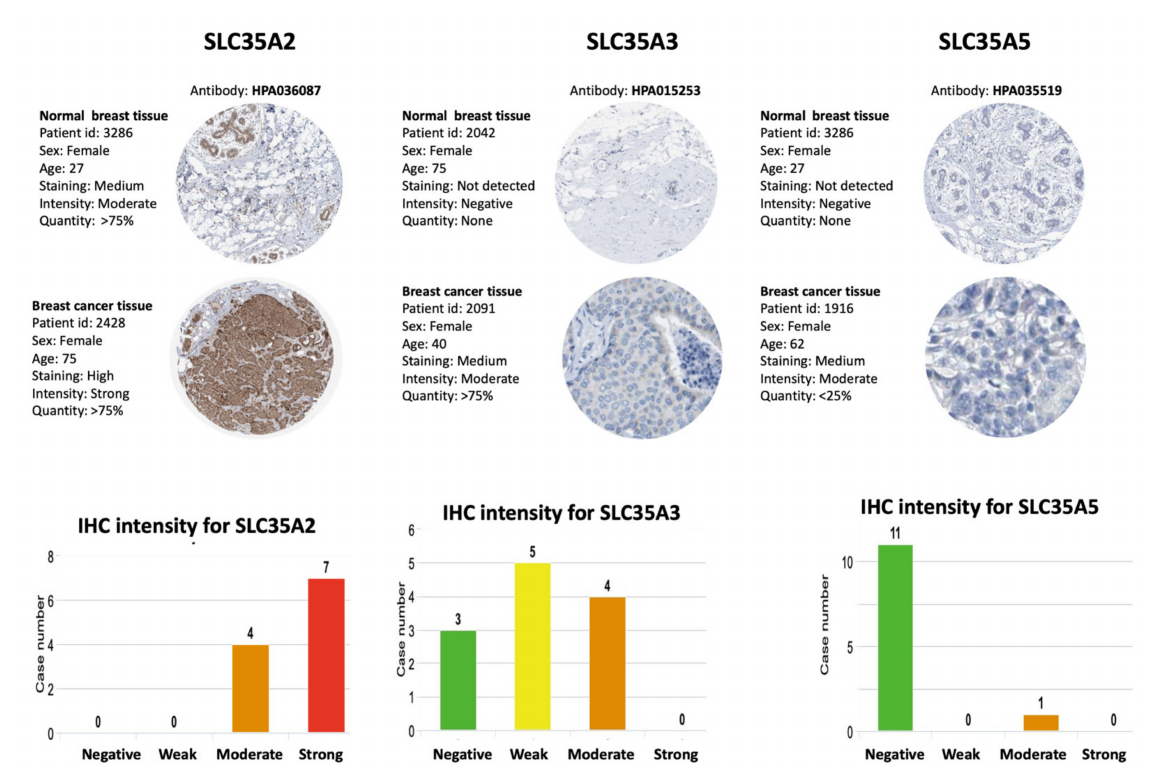
Figure 7. IHC expression patterns of solute carrier 35 A (SLC35A) family members in normal and BRCA tissues. IHC-stained images show the intensities of antibodies in both BRCA and adjacent normal tissues. A bar chart under each IHC stained images means the IHC staining intensity for each SLC35A members (SLC35A2, SLC35A3, SLC35A5,